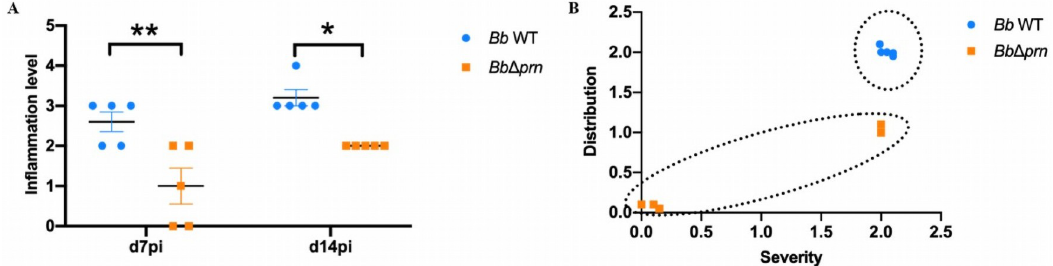
Fig 3. PRN induces inflammation in the nasal cavity. A) Inflammation level in the nasal cavities of mice inoculated with either Bb WT (blue) or Bb Δ prn (orange) at 7-and 14-dpi. B) Mucus accumulation in the nasal cavity of Bb WT (blue) or Bb Δ prn (orange) inoculated mice at day 7 pi. Individual samples from either group are highlighted with dashed circles. The veterinary pathologist conducting the inflammation level analysis (UBM) was blinded to the sample source. There were 5 mice in each time point per group. Error bar shows the standard error of mean. Statistical significance was calculated using Two-way ANOVA. � p < 0.05, �� p < 0.01, ��� p < 0.001.